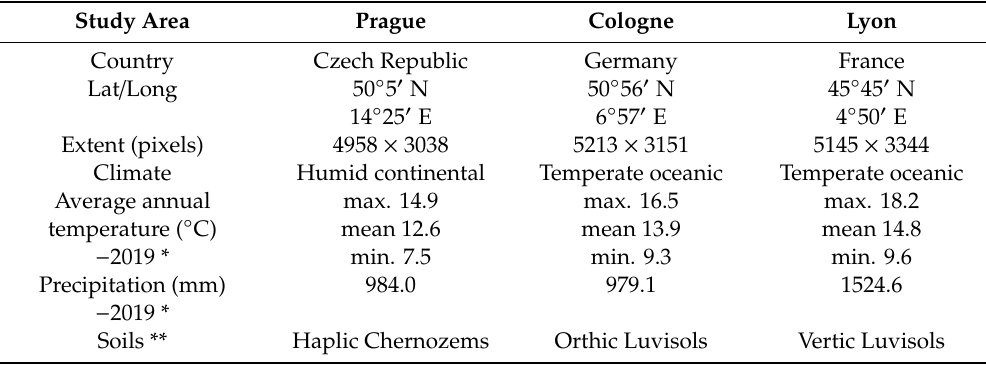
Table A1. Detailed characteristics of the study areas used in this